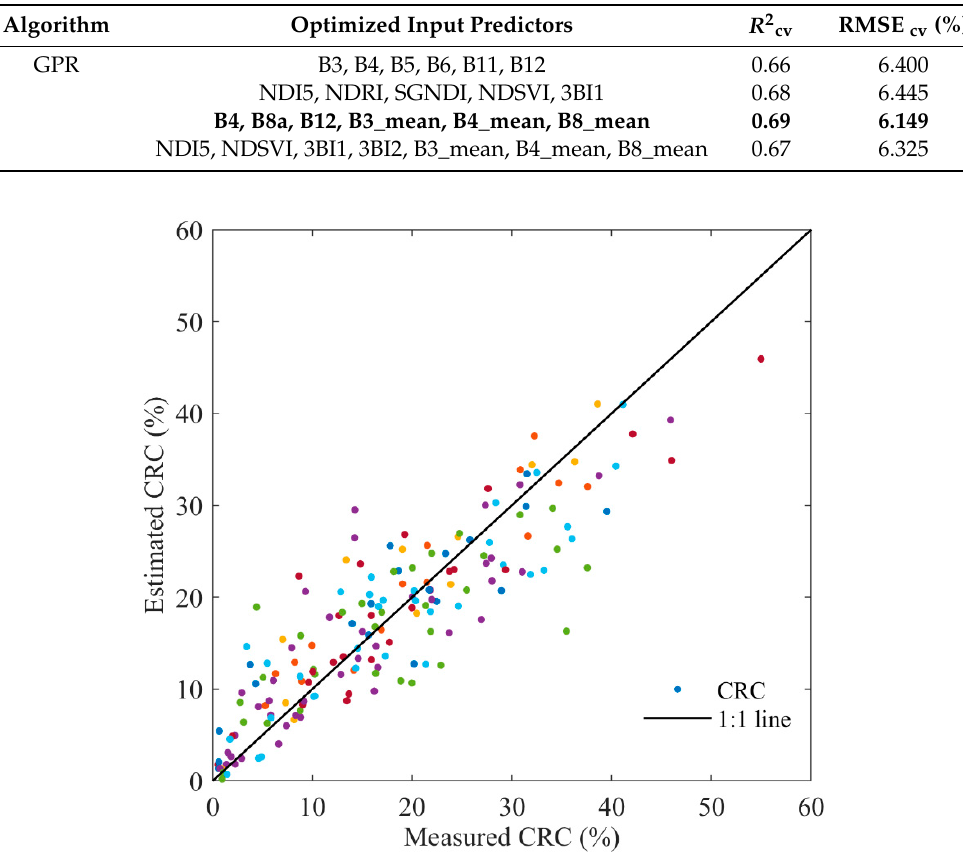
Figure 8. Measured vs. estimated CRC values along the 1:1 line of the best performing GPR mode (see Table 6). The different colors indicated the 10-fold subsets.